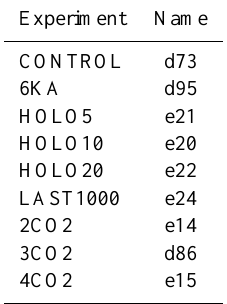
Table A1. The names of the experiments analysed herein.